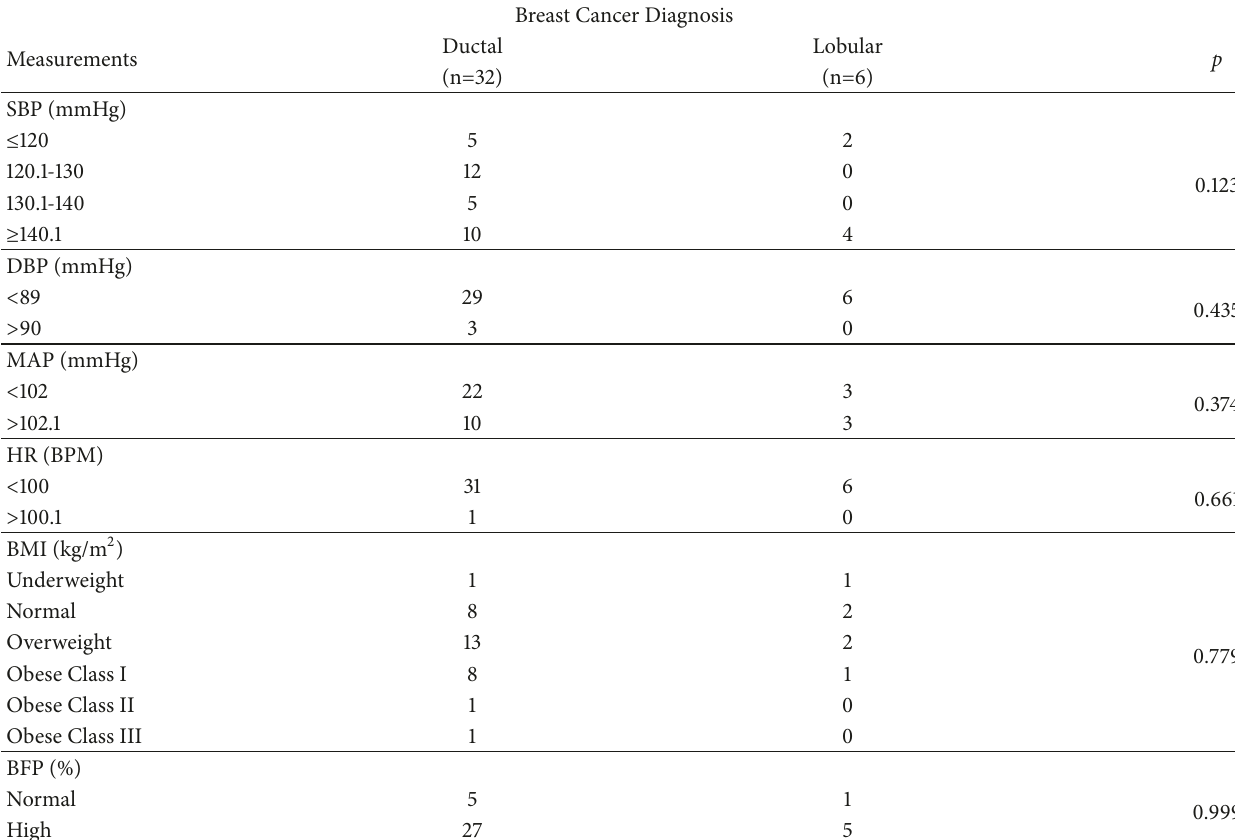
Table 2: Frequency of patients according to baseline classification of blood pressure, BMI, and BFP vs. the type of breast cancer. Breast Cancer